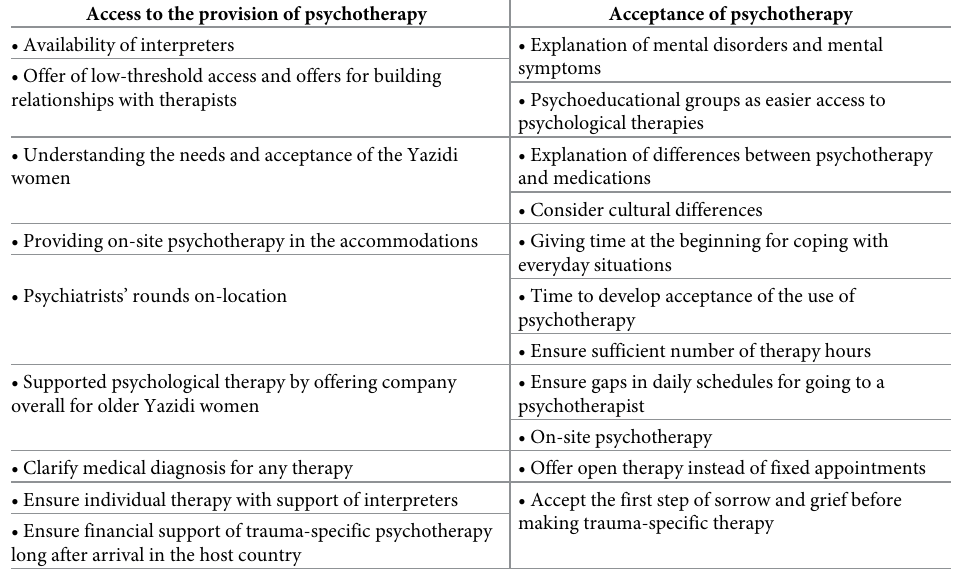
Table 4. Helpful strategies to improve access to and acceptance of psychotherapy for traumatized female refugees.